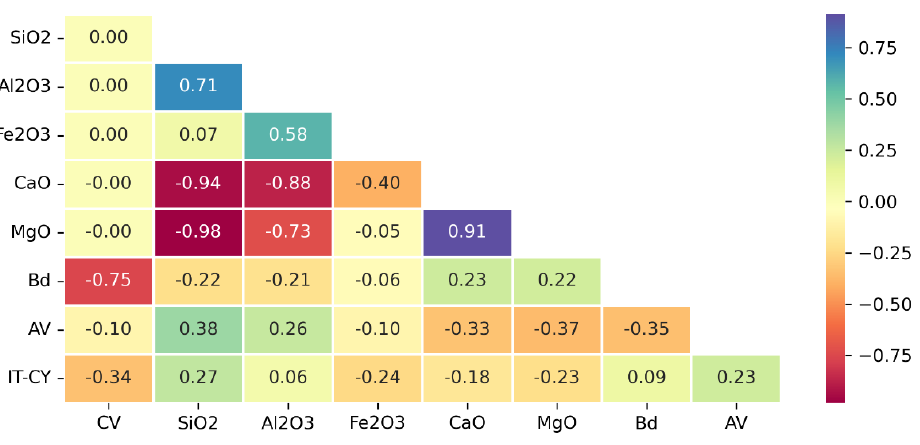
Figure 2. Pearson correlation matrix.